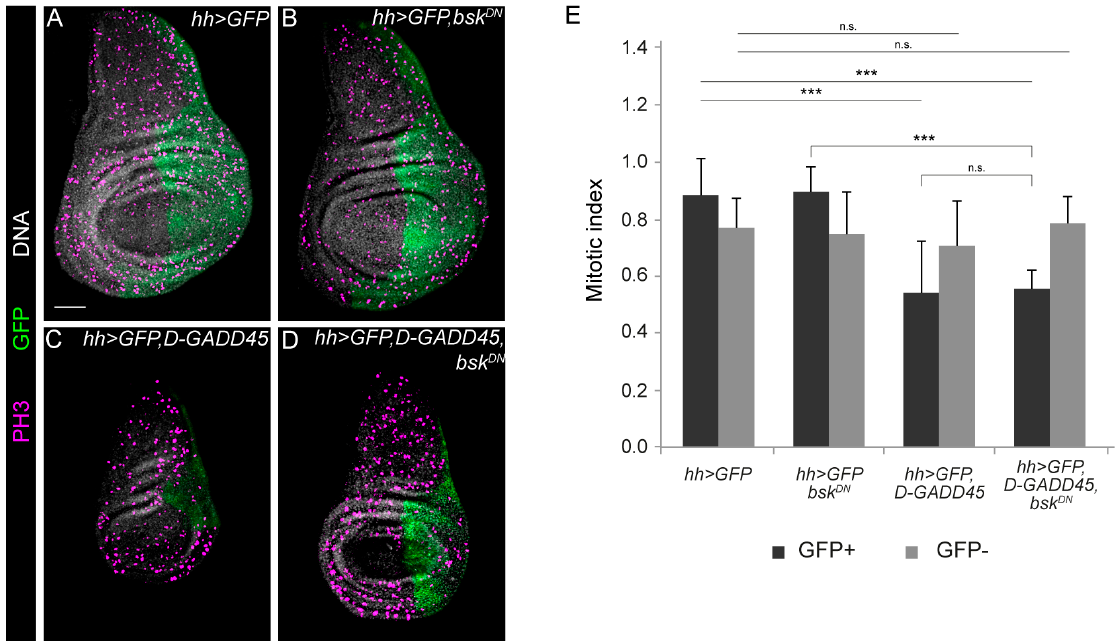
Figure 4. Sustained expression of D-GADD45 decreases cell proliferation independently of JNK activation. ( A–D ) Immunostaining of wing discs with P-histone-H3 labeling mitosis (magenta), the posterior compartment (green) and DNA (white). Scale bar: 50 µ m. ( E ) Histogram showing the mitotic index of PH3 labeling for each genotype in the GFP-positive and GFP-negative compartments. N ≥ 10 for genotype. *** p < 0.001.